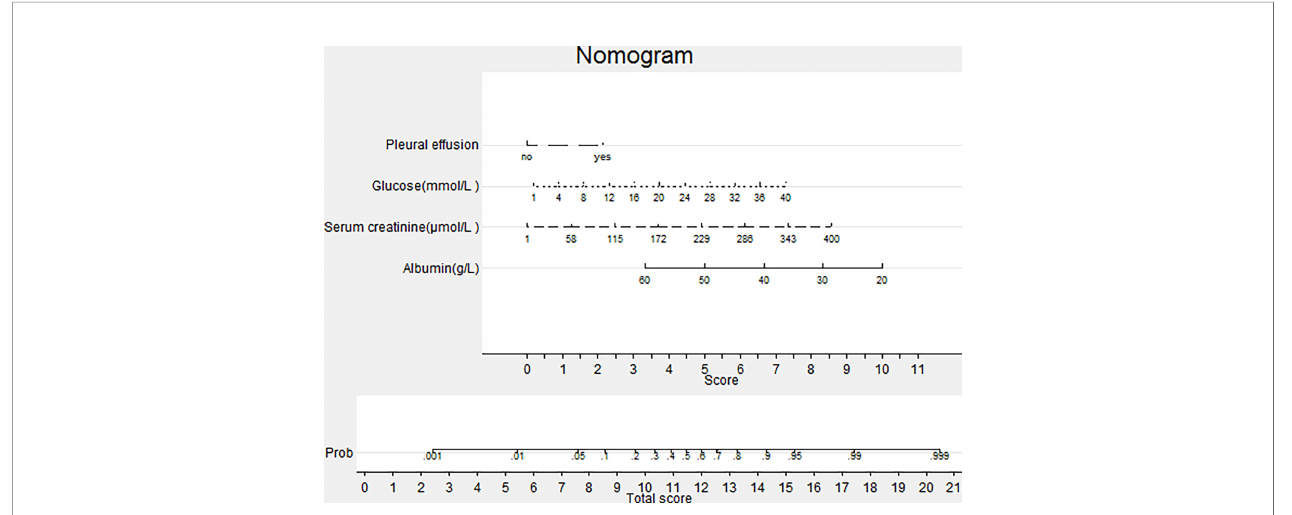
FIGURE 1 | Nomogram predicting the probability of SAP. To obtain the nomogram-predicted probability, patient values on each axis were located and a vertical line was drawn to the point axis to determine how many points were attributed for each variable value. Points for all variables were summed and accessed on the point line to fi nd SAP probability.